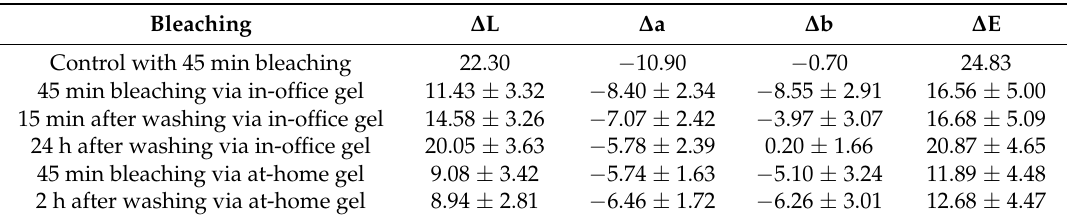
Table 2. Mean ( ± standard deviation) color changes after tooth bleaching via control gel (36% hydrogen Table 2. Mean (± standard deviation) color changes after tooth bleaching via control gel (36% peroxide), at-home gel, and in-office hydrogen peroxide), at ‐ home gel, and in ‐ office gel.